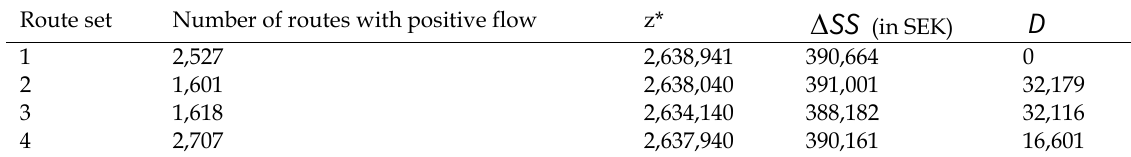
Table 5. Comparison of results from using alternative route flow solutions for defining the set of first-best toll